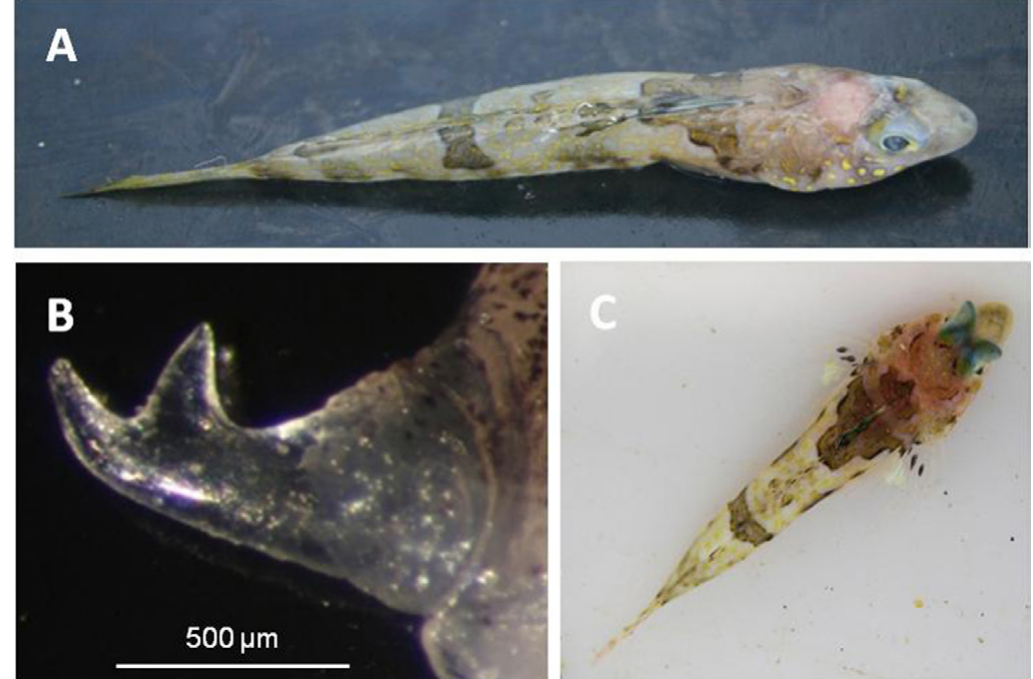
Fig. 3. - Photographs of Protogrammus alboranensis n. sp.: A) holotype CFM_IEOMA 5557, male, 63.8 mm total length; B) dorsal view and detail of the right preopercular spine of the holotype; and C) paratype SMF 35716, female, 30.3 mm total length,